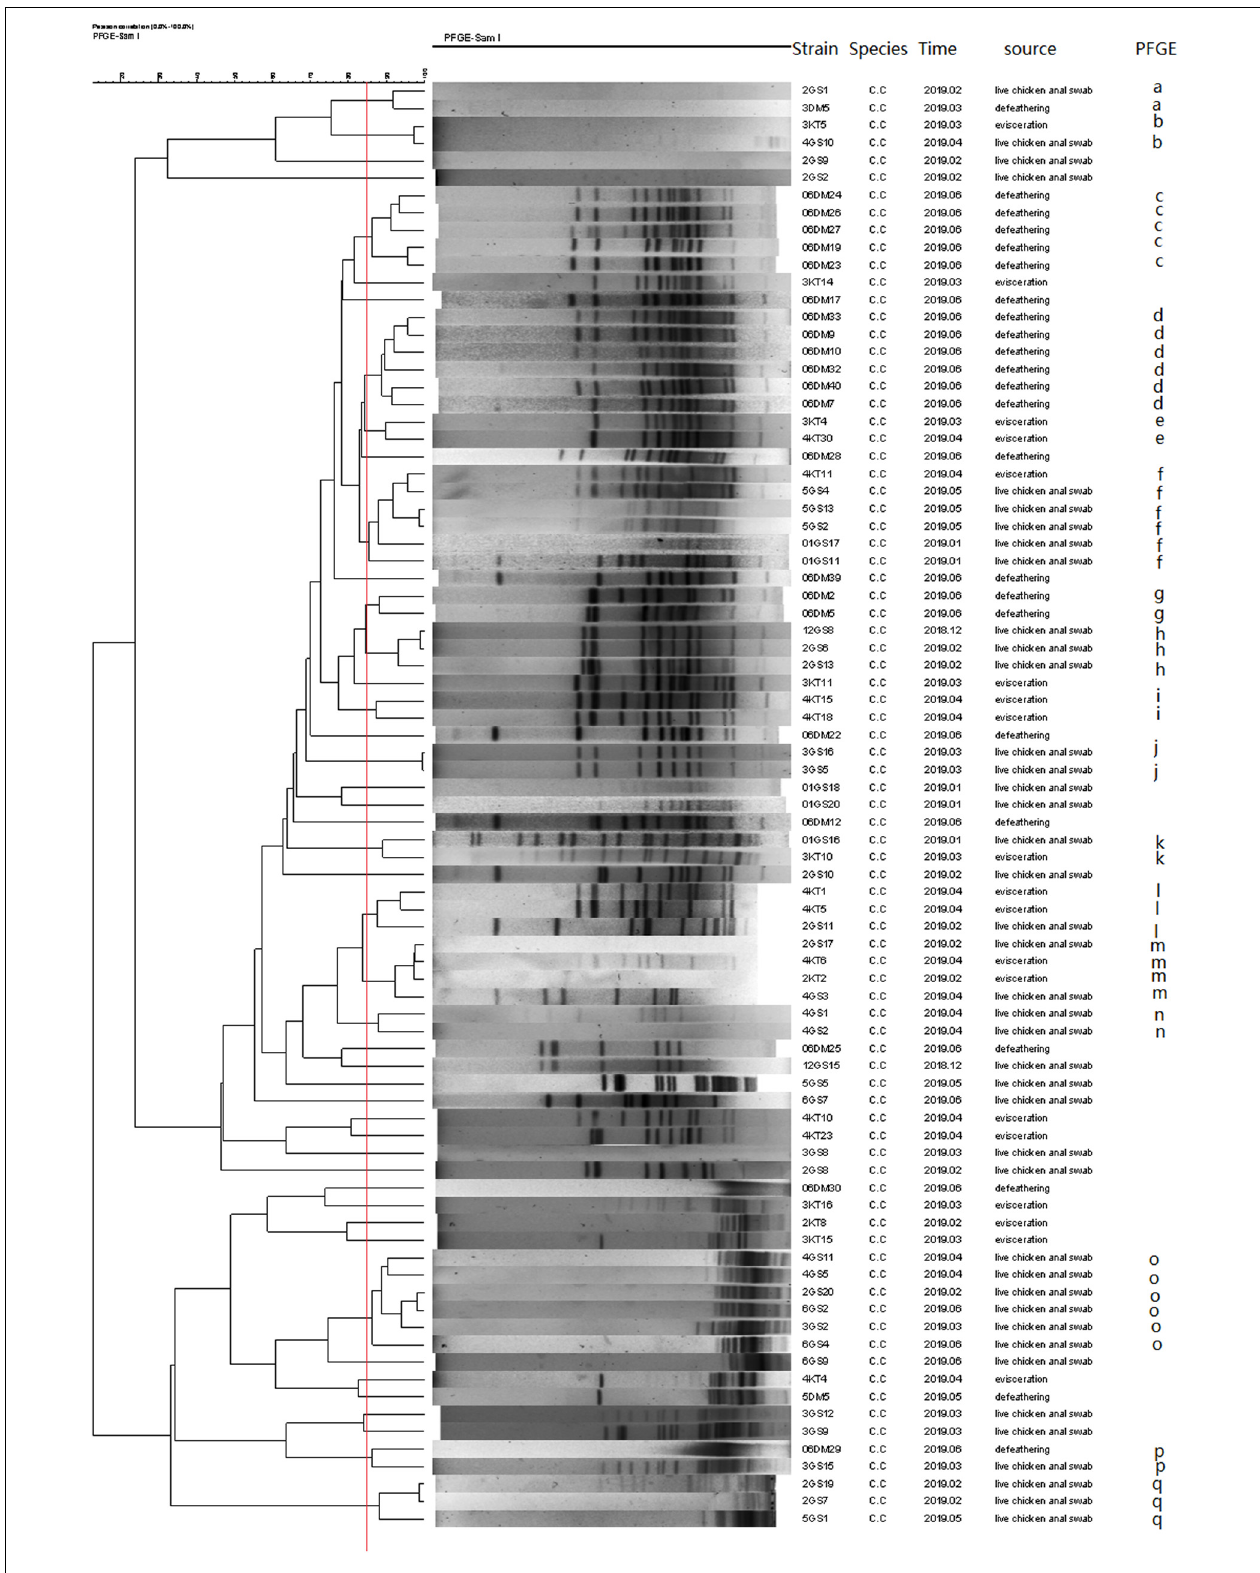
FIGURE 5 | Dendrogram of the Sma I PFGE patterns of 83 C. coli isolates from five stages of the chicken slaughtering chain. (a–q) PFGE patterns.